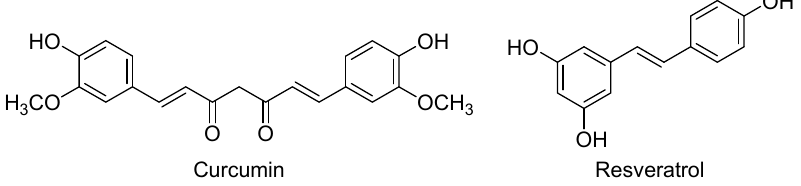
Figure 6. Some activators of the Nrf2-AREs signalling pathway with neurogenic properties.